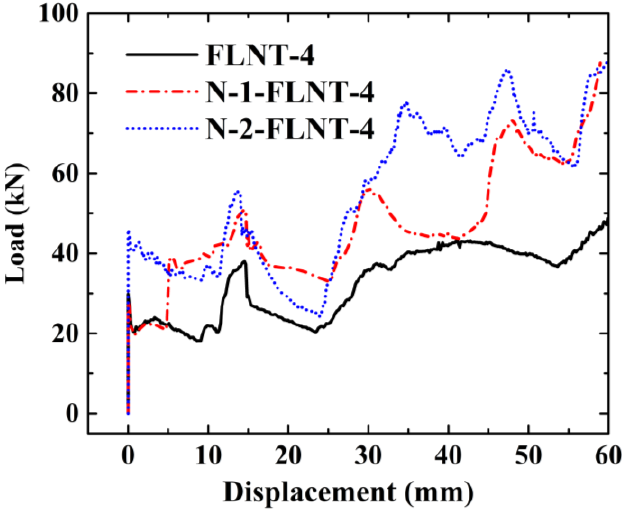
Figure 23. Load – displacement relation of FLNT and N-FLNT-4.